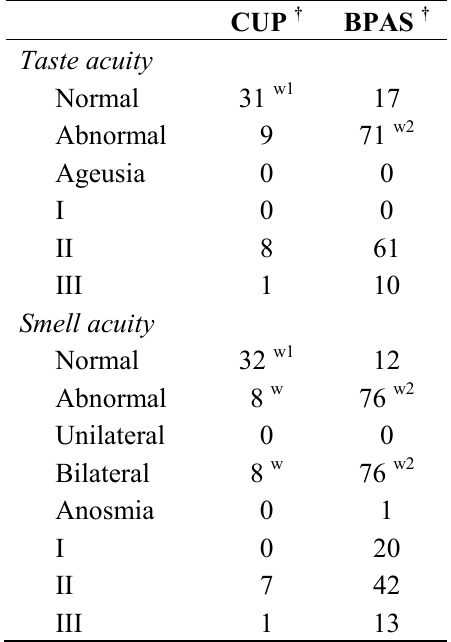
Table 6. Final naris localization in patients with phantosmia with respect to odor character. CUP † BPAS † Final naris odor Final naris odor localization localization Odor character Right Left Birhinal Right Left Birhinal Cacosmic (putrid) Mixed (cacosmic and torquosmic) Torquosmic (burned, metallic, etc